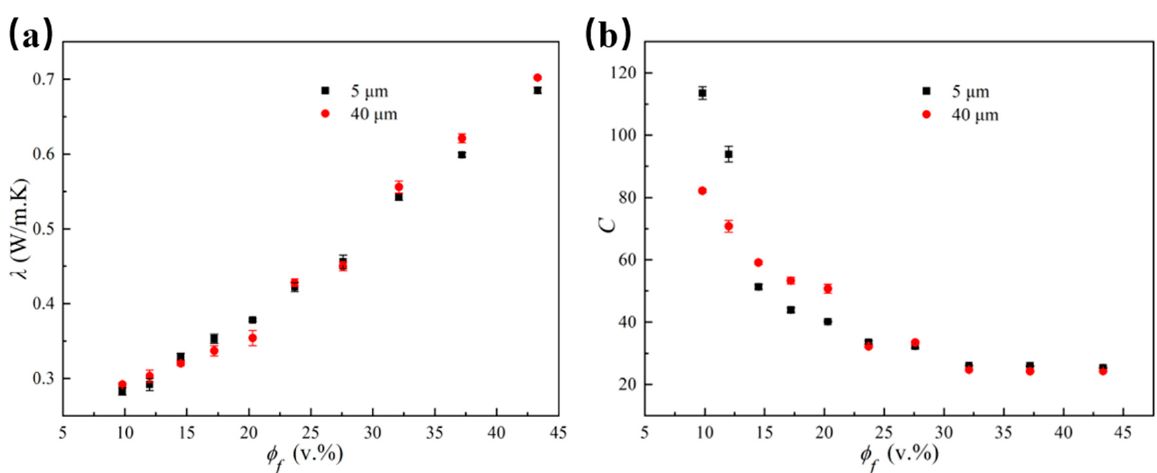
Figure 7. Thermal conductivity and the constant C of LLDPE/Al 2 O 3 composites with two Al 2 O 3 diameters under different Al 2 O 3 volume fractions: ( a ) thermal conductivity; ( b ) constant C.